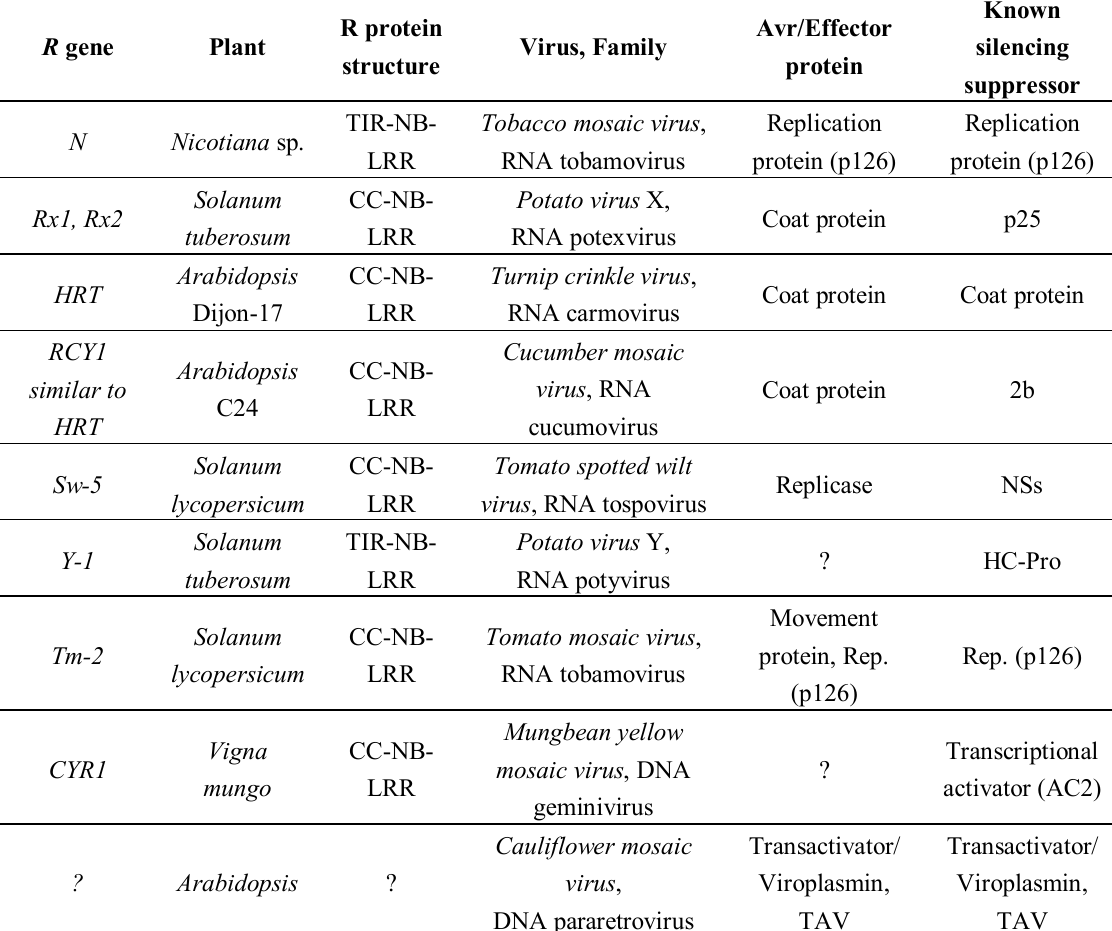
Table 1. Cloned plant R genes and the viral protein effectors and silencing suppressors. R protein R gene Plant